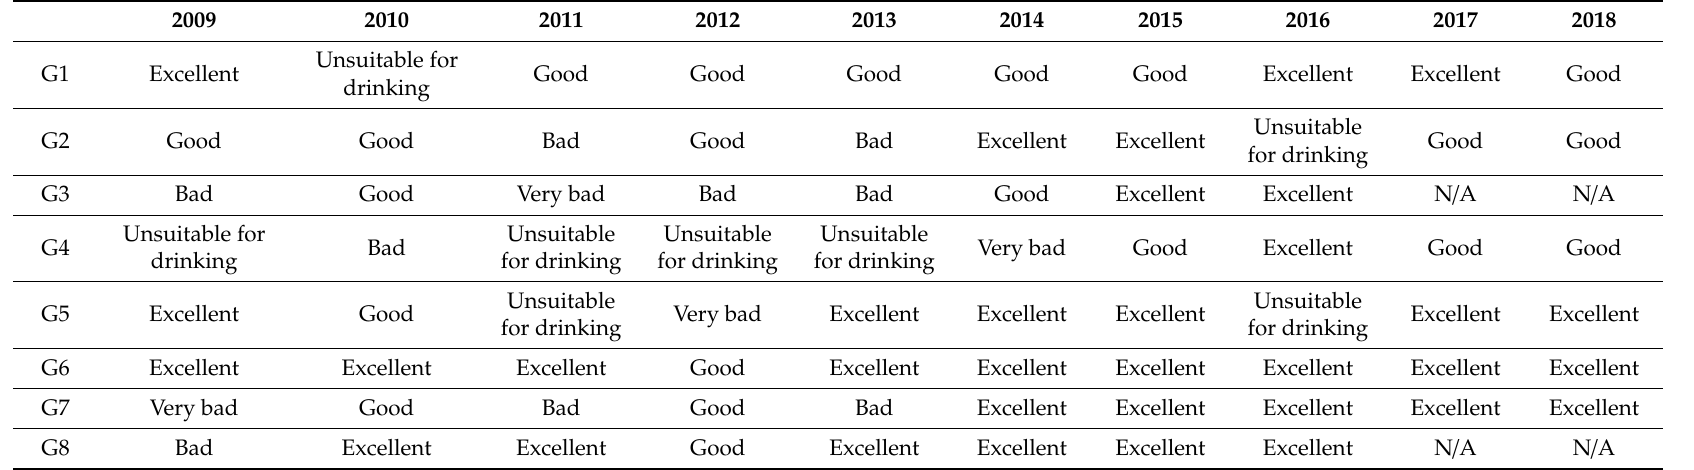
Table A4. Annual Groundwater classification based on WQI in the wet